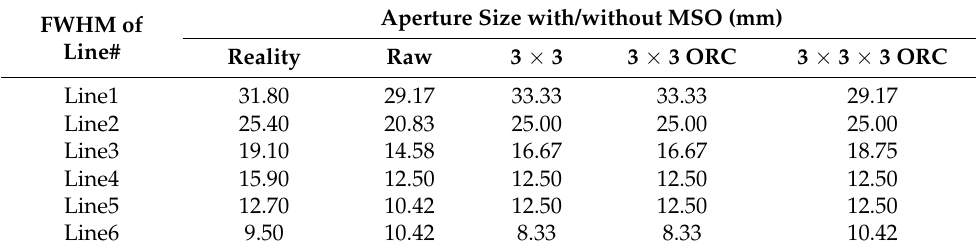
Table 4. The estimated FWHM was compared with